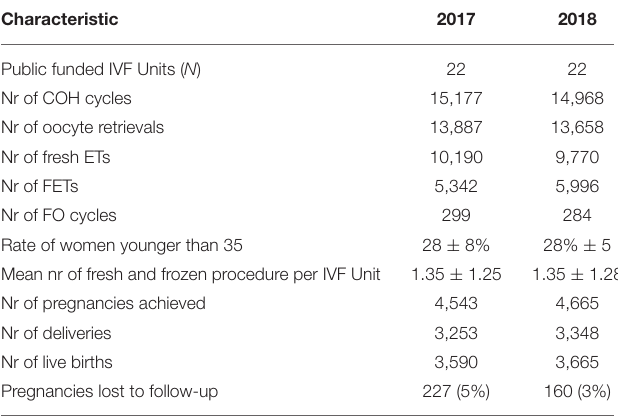
TABLE 1 | Characteristics and outcomes of IVF cycles performed in public funded IVF Units in Lombrdy county in 2017 and 2018.